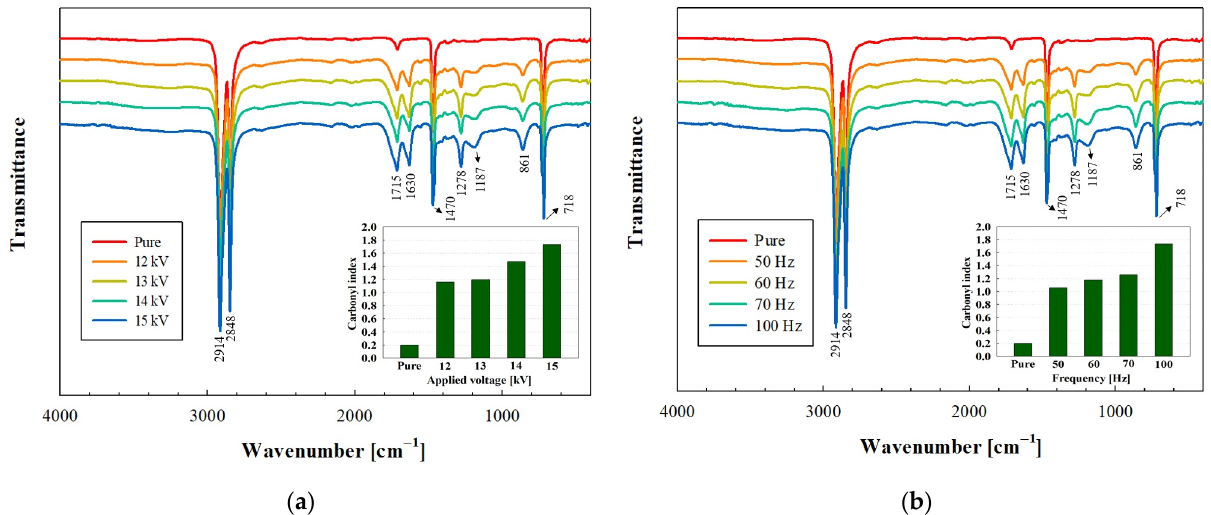
Figure 6. ( a ) FTIR spectra of LDPE at different 𝑉 (cid:3028) ( b ) FTIR spectra of LDPE at different frequen- cies.